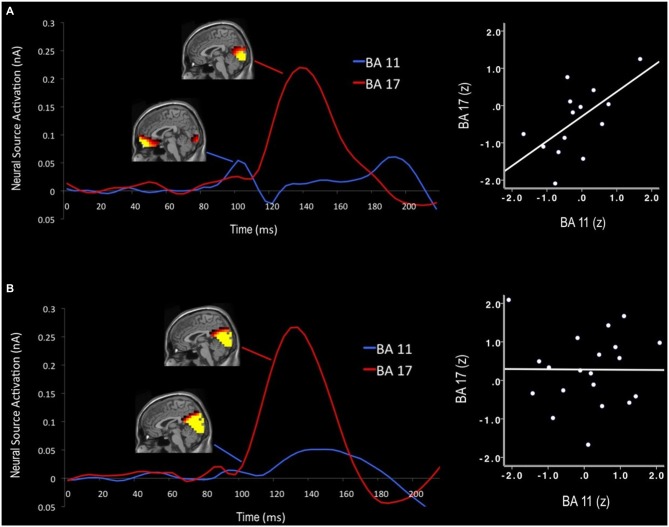
Neural time course of distracter color-gray difference waves for older (A) and younger adults (B). Activation maps display cortical activity at 100 ms and 140 ms that was preferential for color-related distracter processing. Early orbitofrontal cortex (OFC; BA 11) activations predicted subsequent visual cortex activity (BA 17) in older adults, but not for younger adults. Note: Scales visible source activations differ for each time window (100 ms: visible range = 0.06–0.10 nA; 140 ms: visible range = 0.15–0.25 nA).